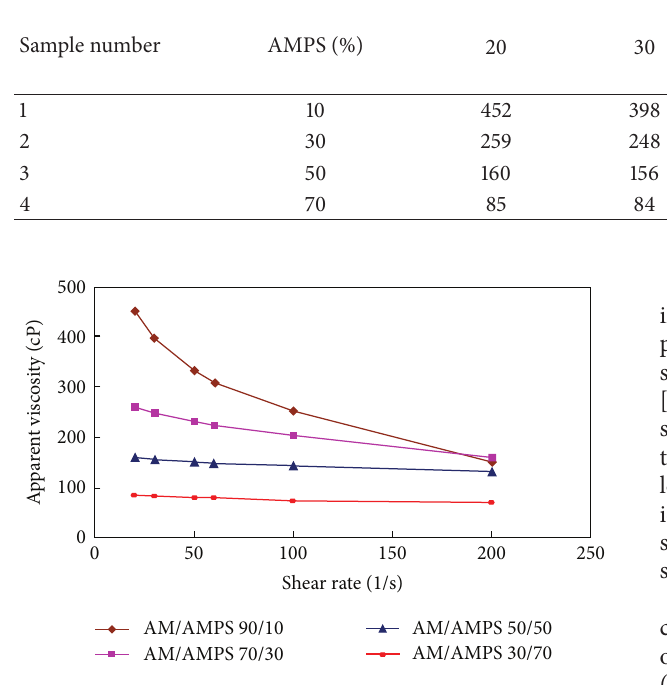
Figure 6: Shear rate dependence of apparent viscosity of a 0.5% (w/w) aqueous solution of copolymers at 25 ∘